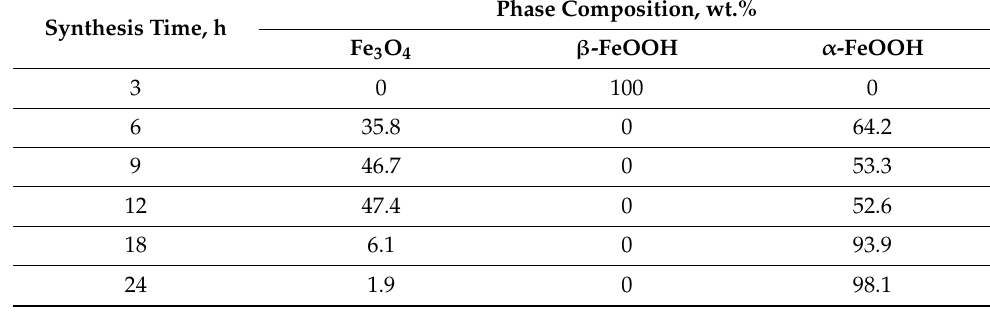
Figure 2. XRD patterns ( a ) and Raman spectra ( b ) of ANPs. Table 1. Phase composition of the samples at different time of the synthesis. Synthesis Time, h